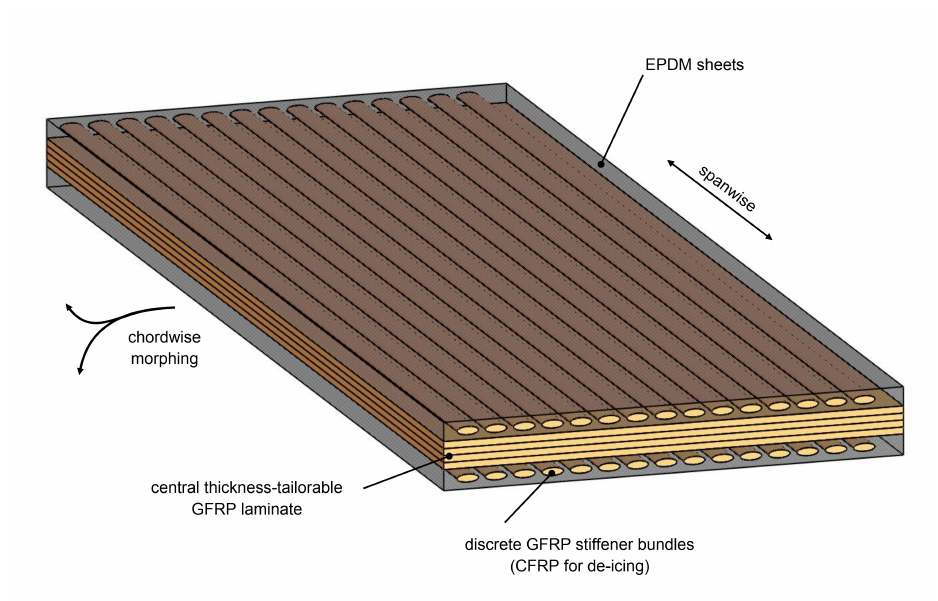
Figure 4. Hybrid skin design with stiffness tailoring.